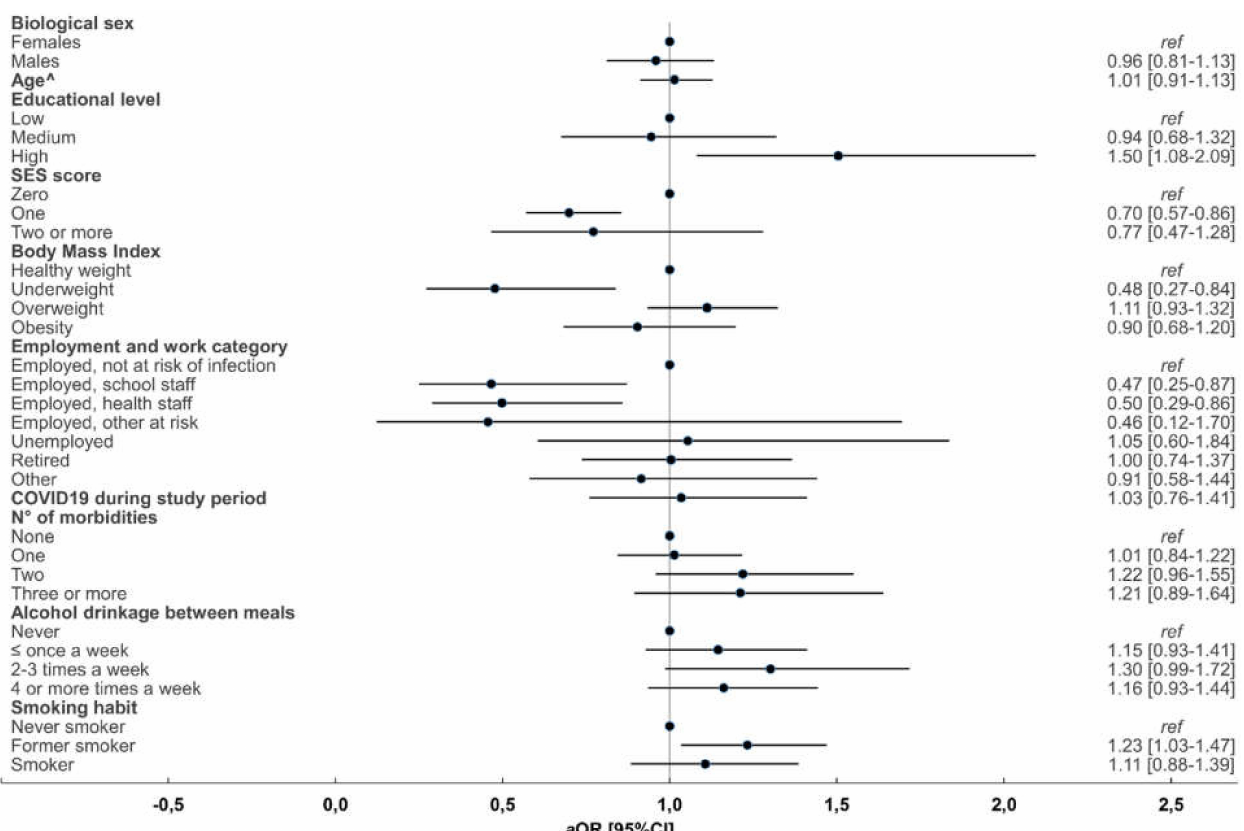
Figure 2. Forest plot of the results from multivariate multinomial logistic regression models of factors associated with flu shot uptake in the 2020/2021 season in respondents aged ≥ 65 years. ˆ For each additional 5 years of age. ref, reference category; a OR, adjusted odds ratios; 95% CI, 95% confidence